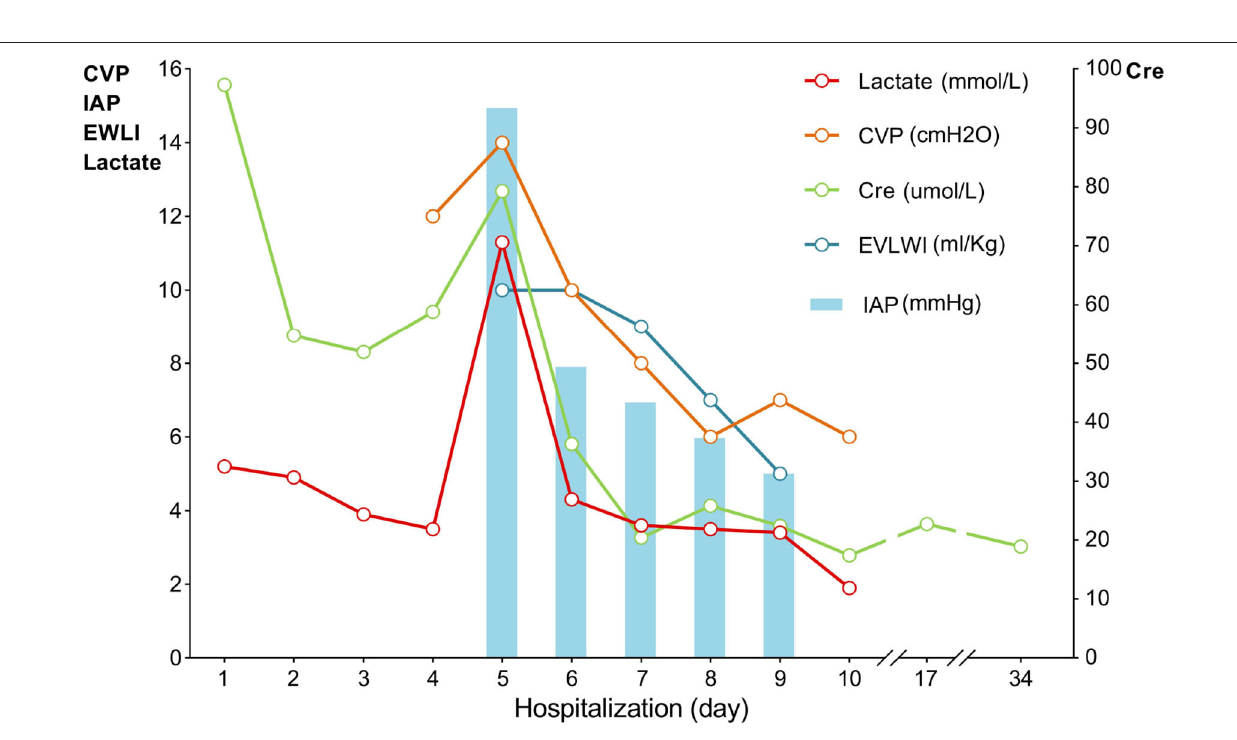
Frontiers in Cardiovascular Medicine |